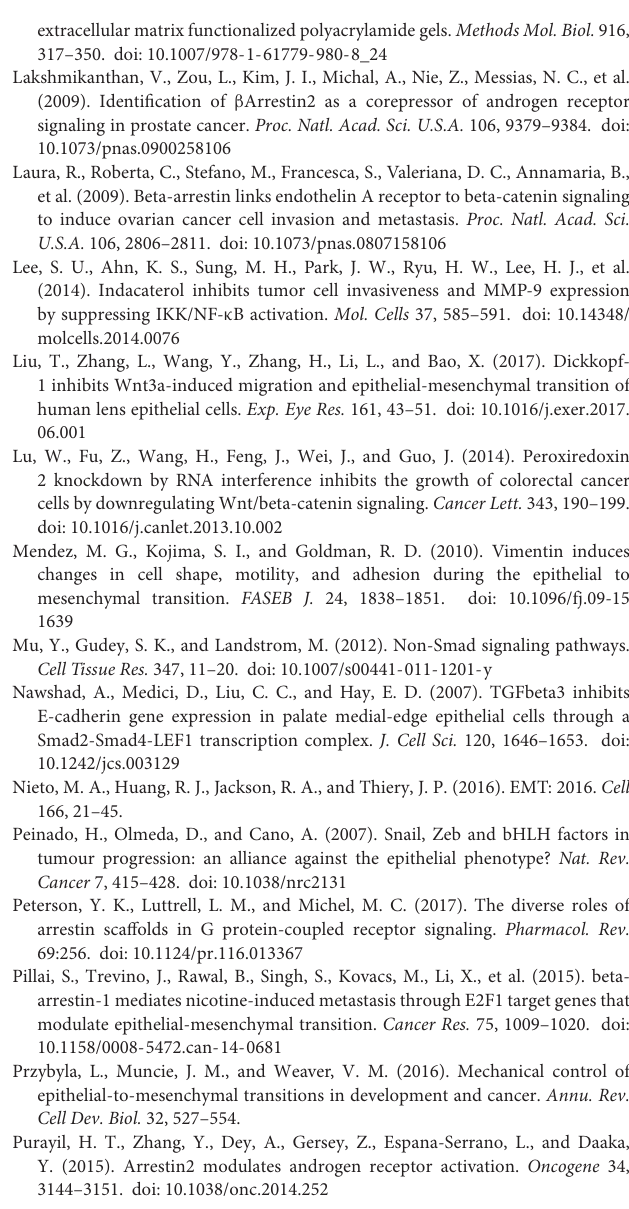
Supplementary Figure 2 | Immunofluorescence dual staining experiment for β -arrestin and E-cadherin (or Vimentin) in HCT-116 or LoVo cells transfected with shRNA/ β -arrestin1 or over/ β -arrestin1 lentivirus. shRNA, short hairpin RNA. Supplementary Figure 3 | β -arrestin1 promotes the invasion of CRC cells. HCT-116 or LoVo cells transfected with shRNA/ β -arrestin1 or over/ β -arrestin1 lentivirus were used in the Transwell experiment. Typical images of cells invaded and migrated in a transwell chamber were captured and quantitatively measured. ∗ P < 0.05; ∗∗ P < 0.01; ∗∗∗ P < 0.001 vs. HCT-116-vector or LoVo-vector cells. CRC, colorectal cancer. Supplementary Figure 4 | The mRNA and protein expression of β -arrestin1 in different groups of Figures 5A,B was validated by reverse transcription quantitative PCR. ∗ P < 0.05; ∗∗ P < 0.01 vs. HCT-116-vector or LoVo-vector